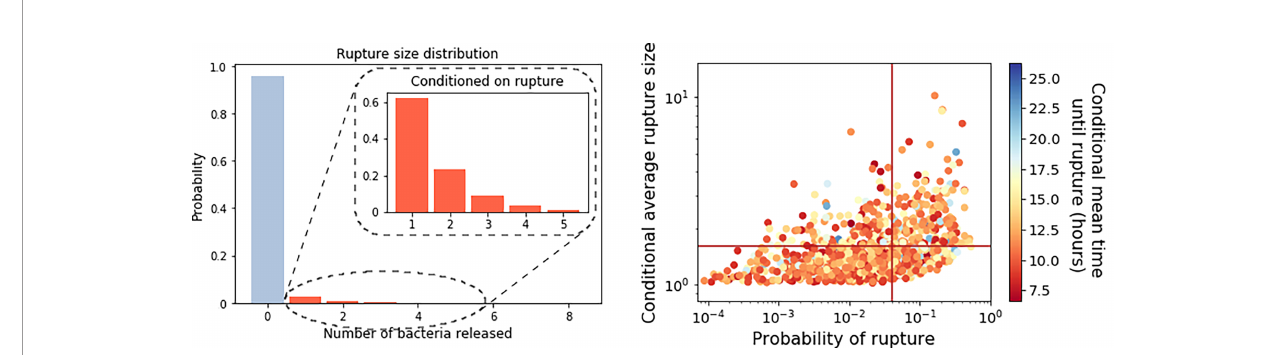
FIGURE 7 | Left: The best predicted rupture size distribution for the model with two types of spores, computed using Eq. (49), with the estimated parameter values from Table 5 . Inset is the conditional rupture size distribution, for the number of bacteria released by a macrophage infected with a single spore, given that it ruptures rather than recovers. Right: Scatter plot of the probability of rupture against the expected rupture size (conditioned on rupture occurring), for each parameter set in the posterior distribution. Lines indicate the values that correspond to the parameter set from Table 5 . The colour of the points indicates the conditional mean time to rupture for each parameter set